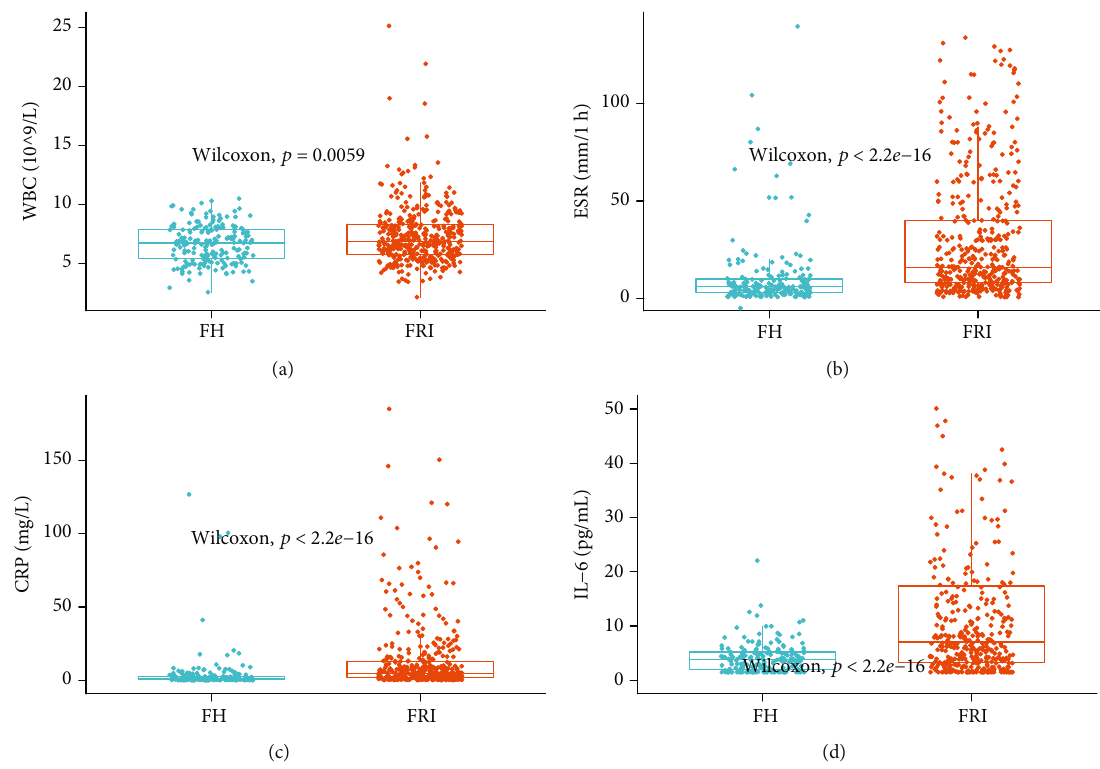
Figure 1: Plots of in fl ammatory biomarkers ’ levels in FRI and FH groups: (a) WBC; (b) ESR; (c) CRP; (d)